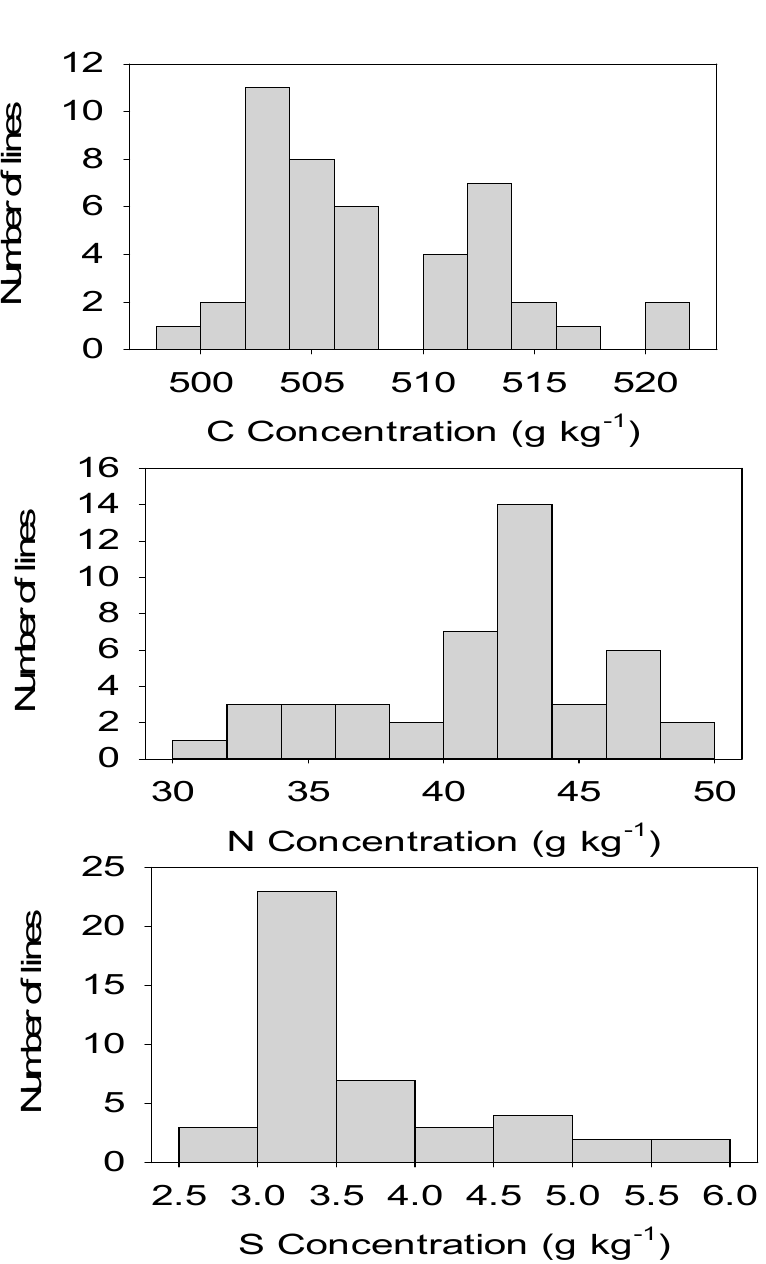
Figure 2. Distribution of macronutrients from top to bottom, respectively, for C, N, and S in cottonseed chromosome substitution lines (CS) across locations. X-axis is nutrient concentration; Y-axis is number of lines.